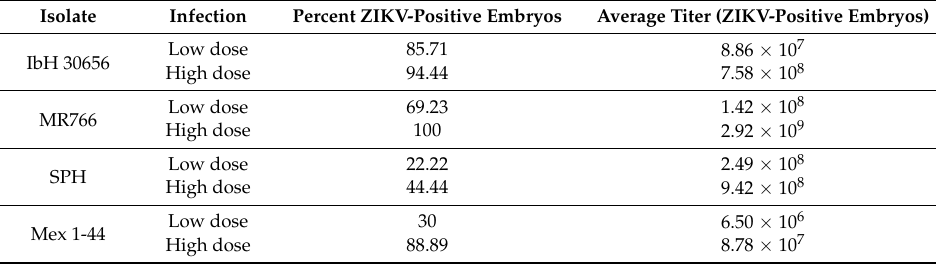
Table 5. Percentage of ZIKV-positive embryos and their average